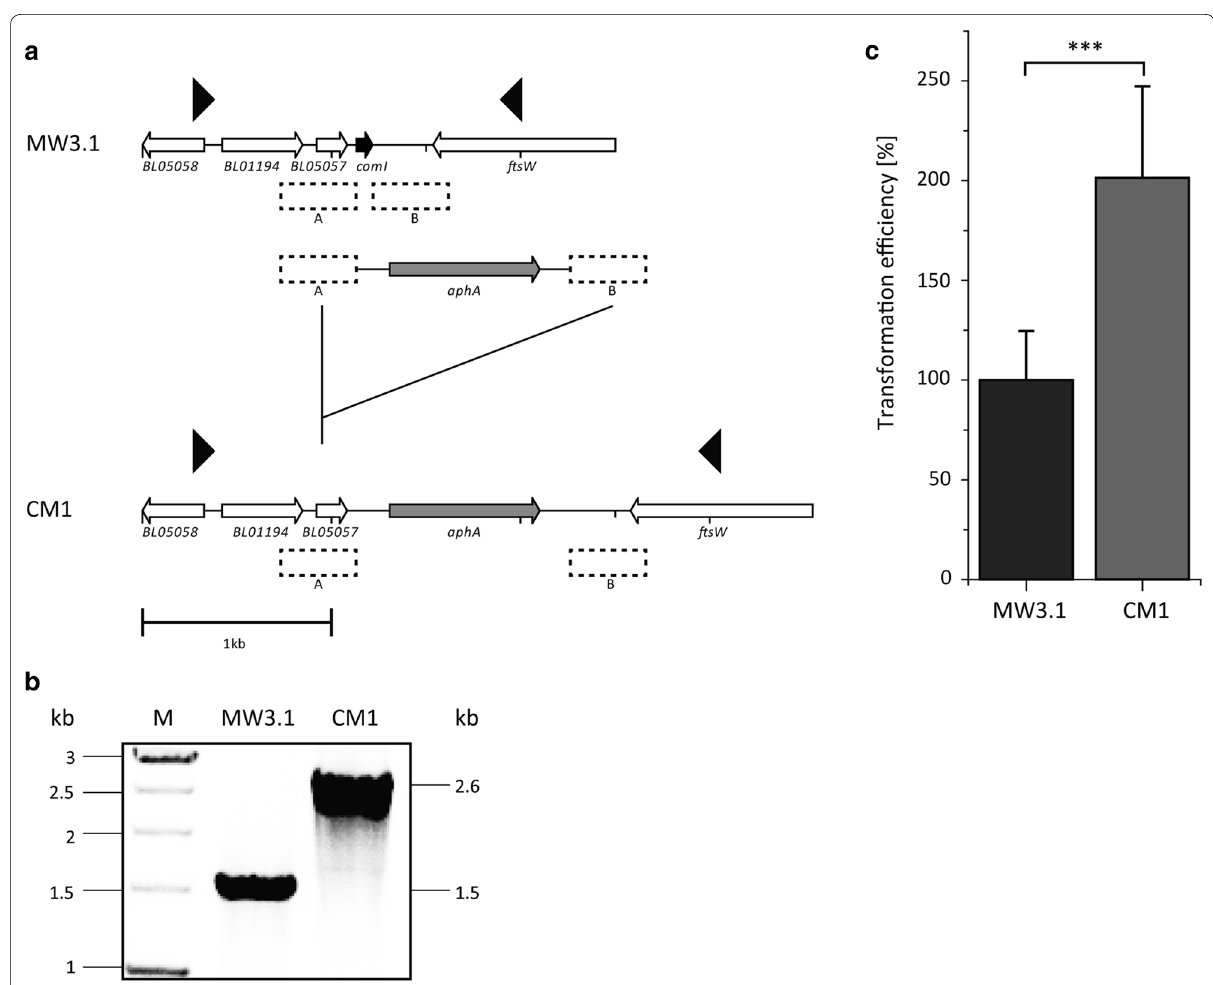
Fig. 2 Elimination of comI in B. licheniformis MW3.1 and its effect on genetic competence. a Schematic overview of the genomic comI region in B. licheniformis MW3.1, the comI substitution cassette and the comI :: aphA substitution strain B. licheniformis CM1. Open reading frames are shown as arrows , primers are depicted as black triangles and recombination flanks are given as rectangles with dashed lines . comI , encodes the putative competence inhibitor ComI DSM13 ; aphA , kanamycin resistance gene; ftsW , cell‑division protein; BL05057 , hypothetical protein of unknown function; BL05058 , putative DNA‑binding protein; BL01194 , putative DNA‑binding protein. b Genotypic verification of the comI :: aphA substitution by PCR using the primers comI_seq_1 and comI_seq_4 and subsequent gelelectrophoretic analysis. c Transformation frequencies of B. licheniformis MW3.1 and B. licheniformis CM1 obtained by natural genetic competence with chromosomal DNA of B. licheniformis ∆ spoIV (Hoffmann et al. 2010) applied to restore uracil prototrophy. The transformation frequency for B. licheniformis MW3.1 was arbitrarily set as 100%. Data are given as mean independent experiments. ***p <